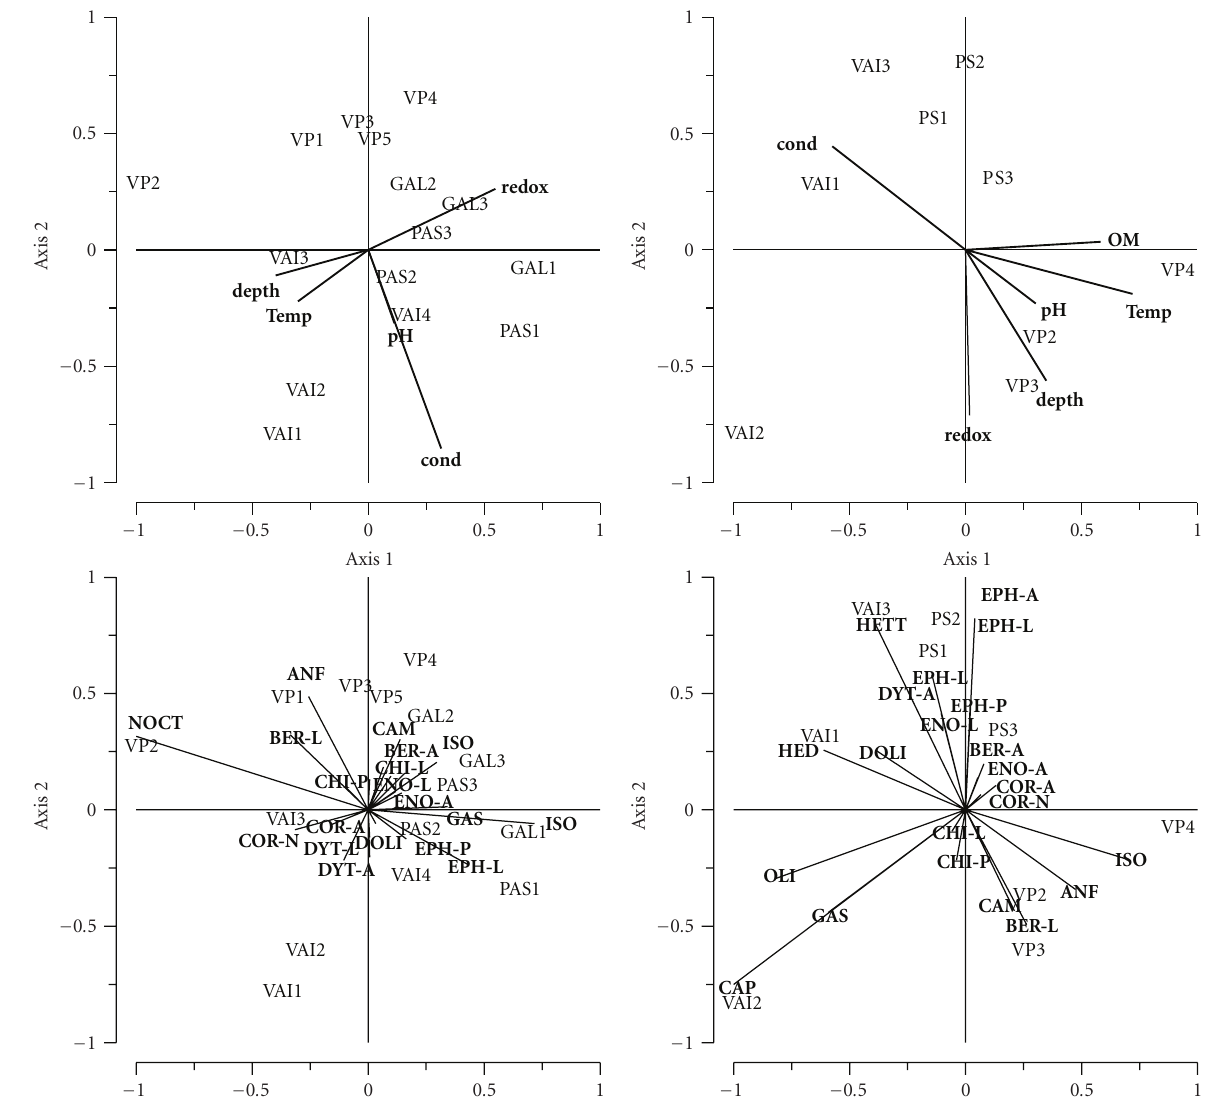
Figure 5: Biplots of sampling points and explanatory variables (up) and biplots of sampling points and response variables (down) from Canonical Correspondence Analysis (CCA) using abundances in 2001 (left) and 2002 (right). 1, 2, 3, 4: pond replicates; VP: Vau; VAI: Vaia; PAS: Passa; GAL: Gala; PS: Praias-Sado; COR: Corixidae; CHI: Chironomidae; BER: Berosus sp.; ENO: Enochrus sp.; DYT: Dytiscidae; CAM: P. varians ; ANF: G. subtypicus ; ISO: L. rugicauda ; EPHY: Ephydridae; ART: A. salina ; CPH- C. insidiosum ; GAS: H. ulvae ; DOLI: Dolicophoridae; NOCT: Noctonectidae; CAP: C. capitata ; HED: H. diversicolor ; HETT: Oligochaeta n.i.; cond: water conductivity (mS cm − 1 ); redox: Redox Potential in water (mV); depth: mean water depth (cm); Temp: water temperature ( ◦ C); OM: percentage of organic matter in surface sediment